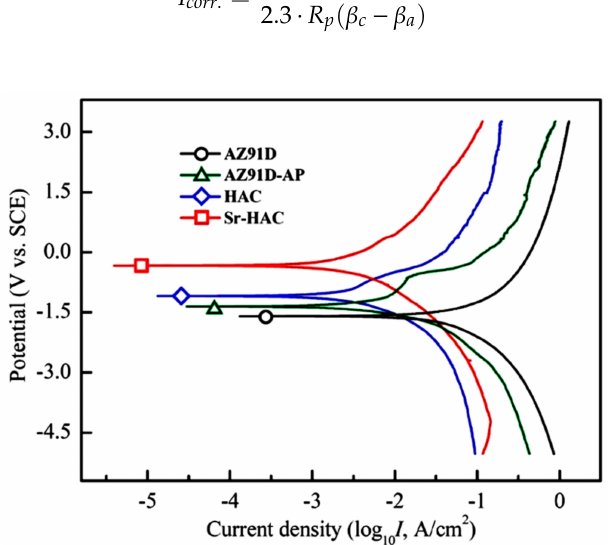
Figure 7. Potentiodynamic polarization curves of the AZ91D alloy, alkaline pre-treated AZ91D-AP, hydrothermally synthesized HAC and Sr-HAC specimens tested in Kokubo’s SBF solution at 37 ◦ C. Parameters β a and β c are the anodic Tafel slope and cathodic Tafel slope,